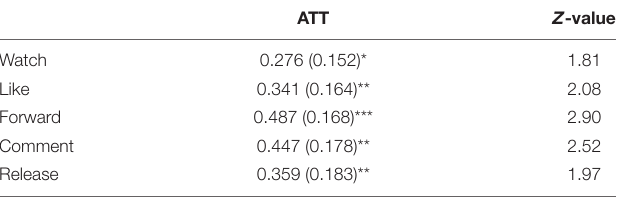
TABLE 6 | Treatment effects of social media participations on farmers’ adoption intensity of LAPs.